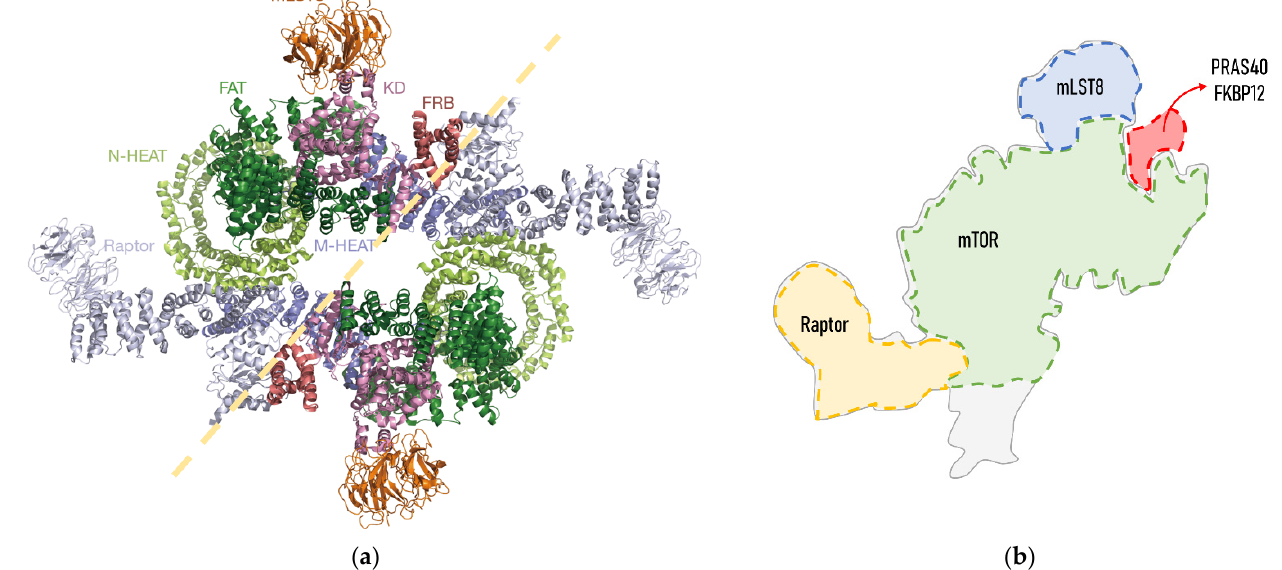
Figure 1. Structure of human mTORC1: ( a ) Cryo-electron microscopy structure obtained from Yang et al., 2018. mTORC1 forms a symmetric dimmer of an heterotrimer consisting of mTOR itself, Raptor and mLST8. The mTOR structure consists of N-terminal HEAT repeats (N-HEAT), an FATD (Frap, ATM, TRRAP domain), an FRBD (FKBP12-rapamycin binding domain) and a C-terminal kinase domain (KD). Each of the domains and subunits are indicated in different colours; ( b ) schematic representation of an mTORC1 heterotrimer and expected binding site of its regulators FKBP12 and PRAS40, adapted from [12,13]. FKBP12 binds to mTOR through its FRBD. The PRAS40 binding domain is structurally very close to that of FKBP12, as it binds to an α -helix from the FBD and to mLST80.